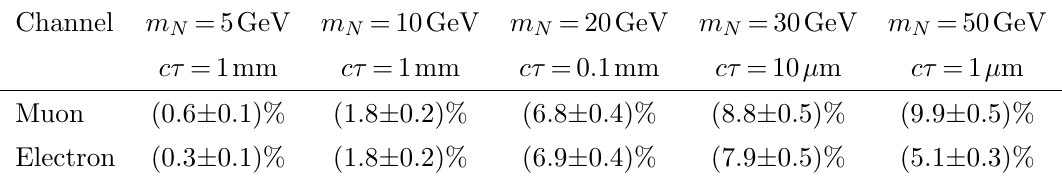
Table 2. Prompt-trilepton signal e(cid:14)ciencies for muon and electron channels after applying all selection criteria. The uncertainties are statistical